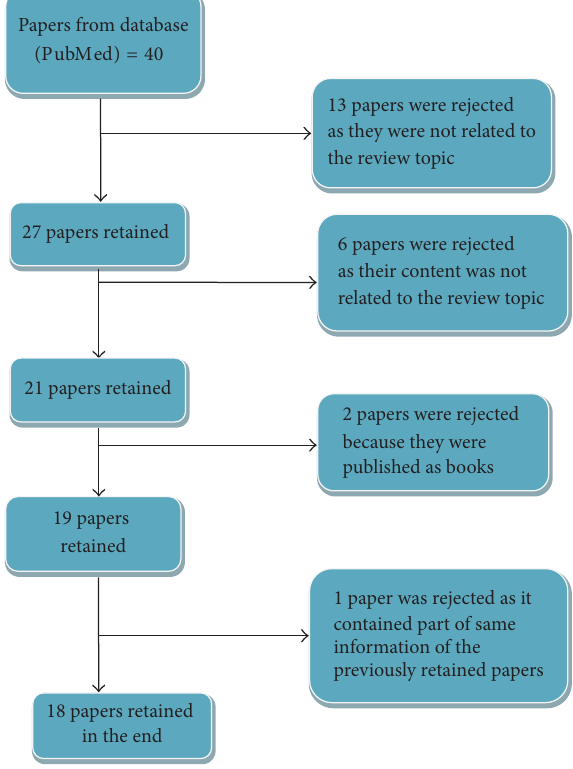
Figure 1: Flow diagram of paper